Question: Which visualization type does this figure use?
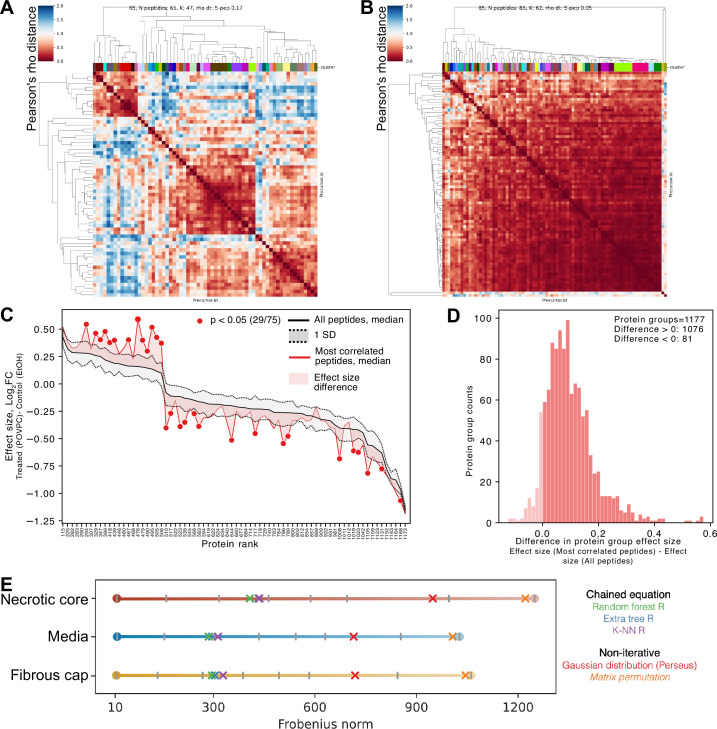
Answer: heatmap